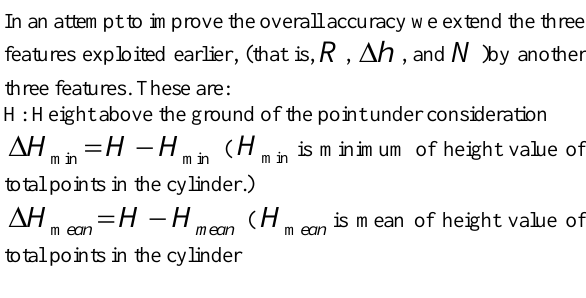
Figure 1. Cylinder placed around a point of consideration with pre-specified radius; the height is determined by the lowest and highest